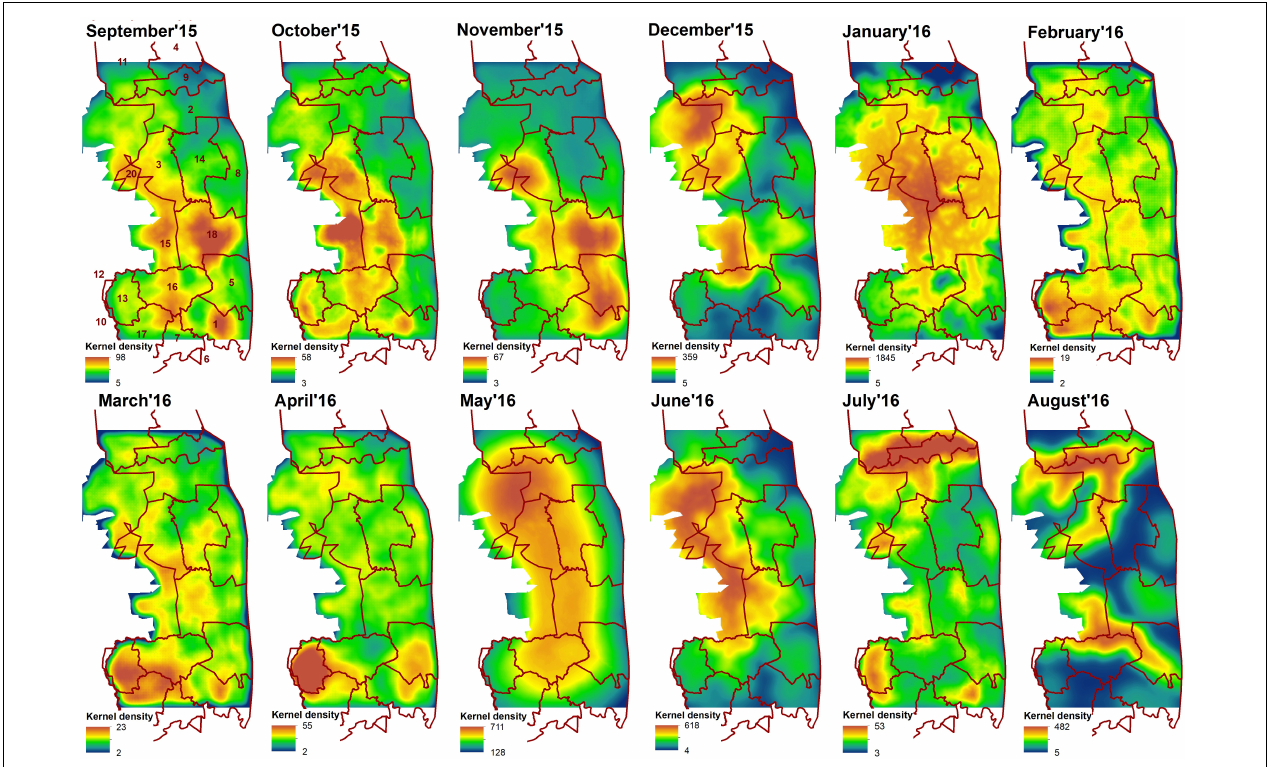
FIGURE 4 | Cumulative resistant kernels surfaces developed for each month from September 2015 to August 2016. Red line indicate sections of Kruger National Park: 1- Crocodile Bridge; 2- Houtboschrand; 3- Kingfisherspruit; 4- Letaba; 5- Lower Sabie; 6- Mjejane Contractural; 7- Malelane; 8- N’wanetsi;9- Olifants; 10- Pretoriuskop; 11- Phalaborwa; 12- Pretoriuskop (outside KNP); 14- Satara; 15- Skukuza/private reserves (outside KNP); 16- Skukuza; 17- Stolsnek; 18- Tshokwane. Dark blue indicates areas of low density elephants’ movement and dark red—areas of high density